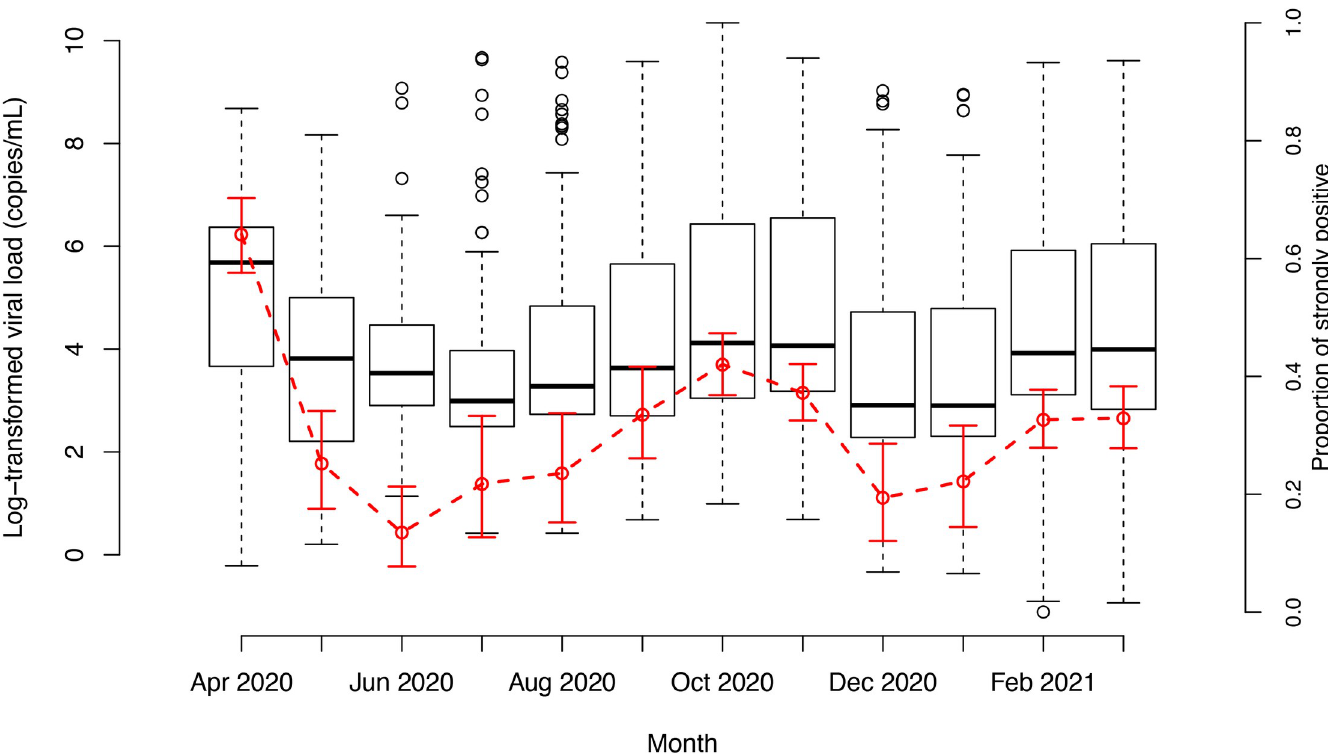
Fig 3. Boxplots showing the evolution of the (distribution of the) log-transformed viral load (in copies/mL) for SARS-CoV-2 positive a-/pre-symptomatic patients by month (from 1 April 2020 to 31 March 2021) and the evolution of the percentage of strongly positive patients among the SARS-CoV-2 positive a-/pre- symptomatic patients by month (red dots) with pointwise 95% exact Clopper-Pearson confidence intervals.